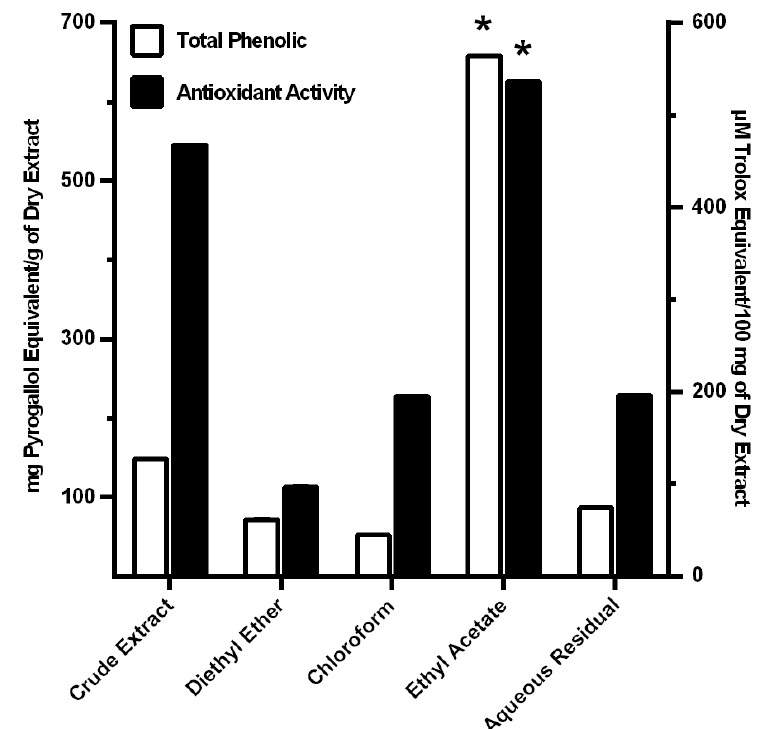
Figure 1. Fractionation of the phenolic and antioxidant activity of Moringa oleifera . Total phenolic content was measured by Folin-Ciocalteau method and expressed as mg Pyrogallol equivalen/g of dry extract ( □ ). Antioxidant was measured by ABTS radical cation decolorization assay and expressed as μ M Trolox equivalent/100 mg of dry extract ( ■ ). Results were analyzed from triplicate data of experiments. * p < 0.01 by ANOVA, compared to crude extract and other